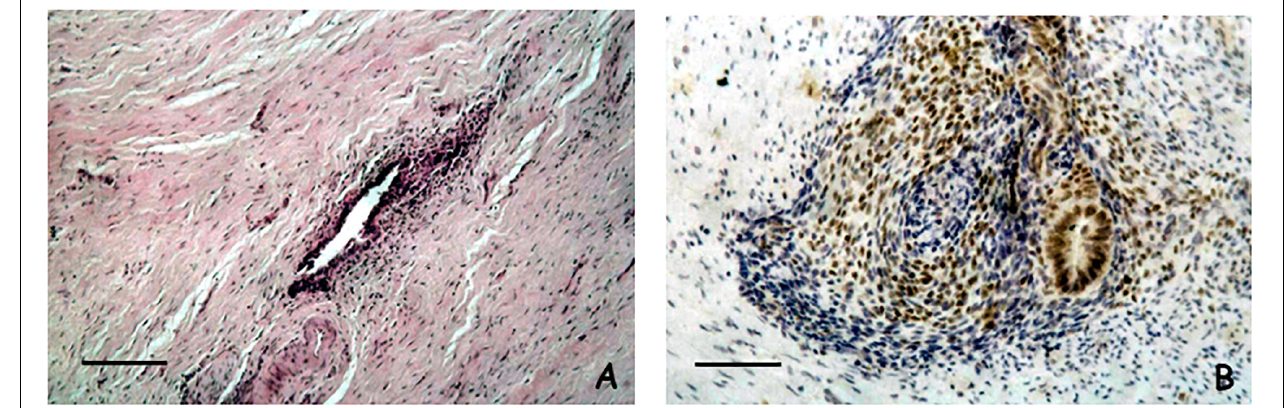
FIGURE 1 | (A) Microscopical appearance of a case of ectopic endometrium found in the Douglas pouch. The histological section shows an endometriotic gland and a thin cuff of peri-glandular endometriotic stroma (Scale bar = 100 µ ) (Hematoxylin and Eosin, original magnification × 20). (B) Immunohistochemical analysis of estrogen receptor in a case of ectopic endometrium found close to the posterior wall of the uterus. Both the endometriotic gland and the peri-glandular stroma display reactivity for estrogen receptor (Scale bar = 100 µ ) (Immunohistochemical staining performed with the Avidin-Biotin Complex methodology, original magnification ×